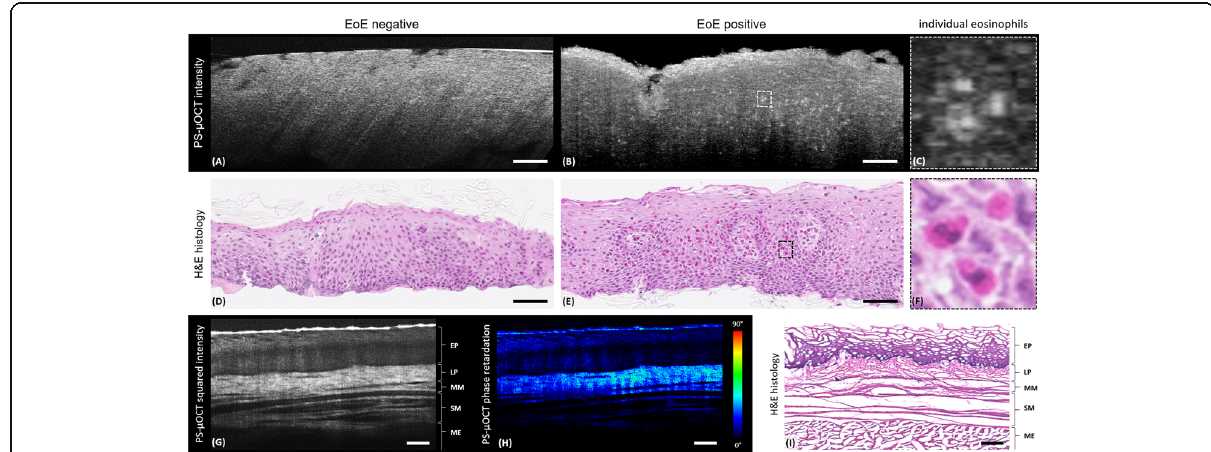
Fig. 10 Proposed EoE diagnostic technology: µOCT imaging ( a )-( c ) and H&E histology ( d )-( f ) results from an EoE biopsy study. Biopsies from EoE patients were imaged within 60 minutes after being obtained by routine WLE guidance. a and b depict exemplary EoE negative (no eosinophils) and EoE positive intensity scans, respectively. d and e depict corresponding histology results. The hyperreflective small spherical structures in (B) were confirmed to be eosinophils by histology ( e ). c and f present magnifications of the indicated areas in ( b ) and ( e ) showing individual eosinophils. g - i depict PS-µOCT imaging results from a first esophageal tissue study in swine, ex vivo . g depicts the squared intensity image clearly indicating the epithelium (EP), lamina propria (LP), muscularis mucosa (MM), sub-mucosa (SM) and muscularis externa (ME). h depicts the corresponding phase retardation image highlighting lamina propria as birefringence expressing layer (natural collagen content). i depicts the corresponding H&E histology showing the same layered structure as the PS-µOCT images. Scale bars: 100